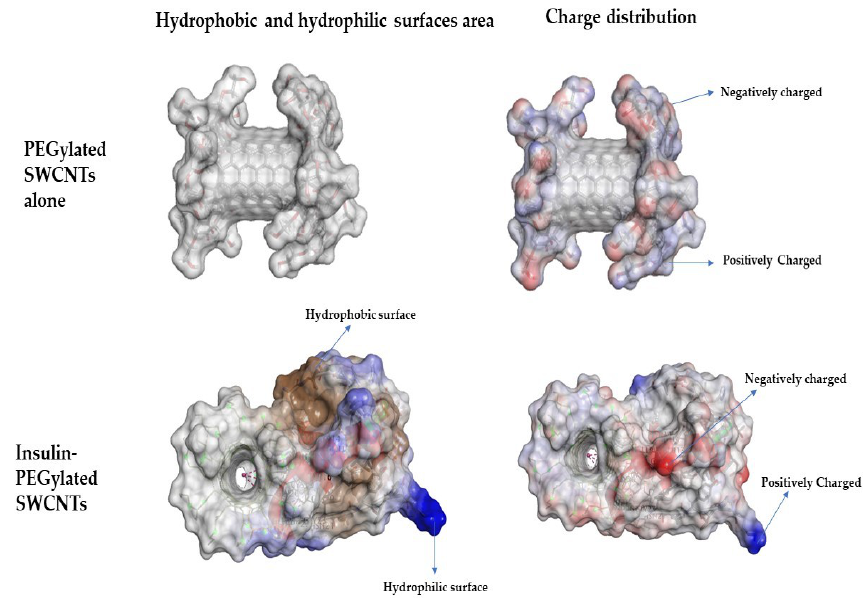
Figure 2. Representation of hydrophilic, hydrophobic, and charge distribution over the non-covalent functionalization of insulin hormone on PEGylated SWCNT and PEGylated SWCNT functionalization of insulin hormone on PEGylated SWCNT and PEGylated SWCNT alone. The Discovery Studio visualizer is used for visualization of the hydrophobic, hydrophilic and charge surfaces.